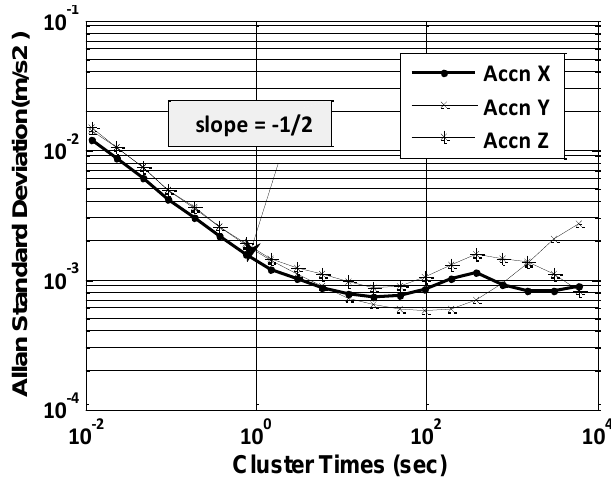
Figure 5. Allan variance for accelerometers.